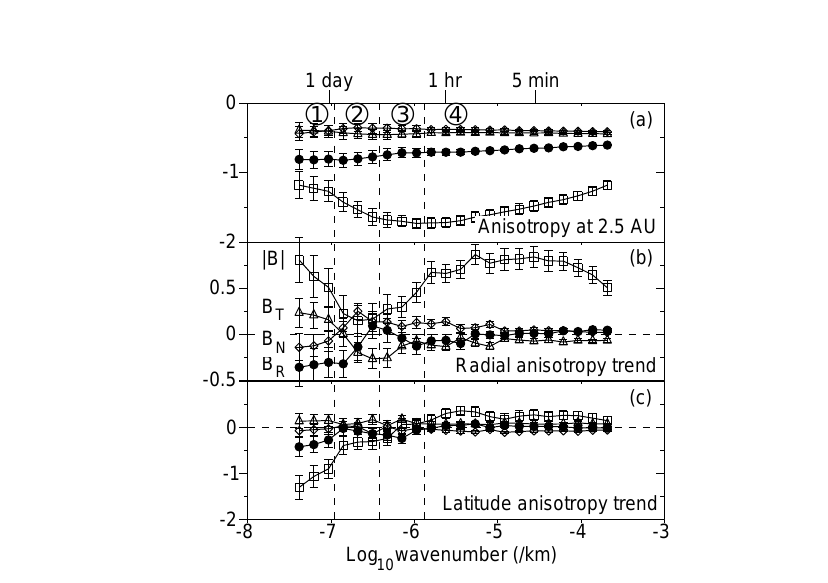
of the ratio of 𝐵 𝑅 10